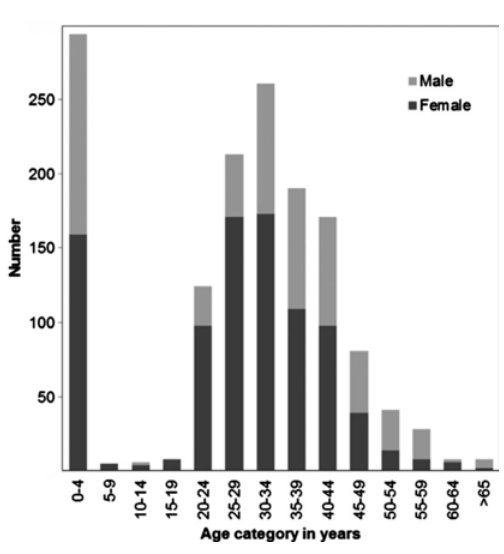
*: Age and gender were not available for 6% (99/1 537). Figure 1: Age and gender distribution for patients with laboratory- confirmed Pneumocystis jirovecii pneumonia reported to the Group for Enteric, Respiratory and Meningeal Disease Surveillance in South Africa programme, South Africa, 2006–2010 ( n = 1 438) 39